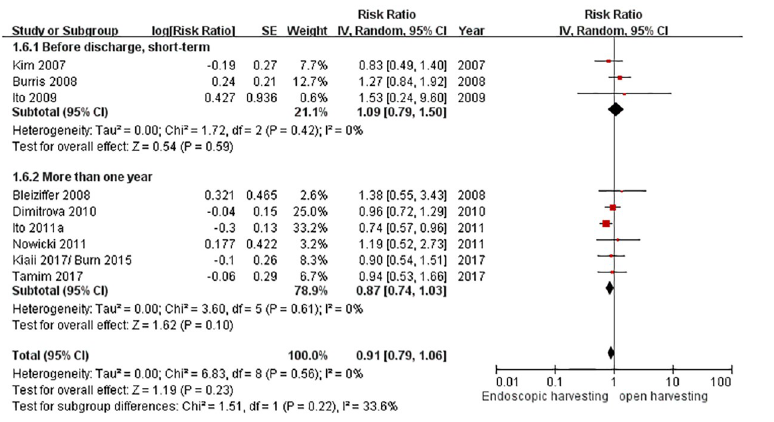
Fig 8. Forest plot for the patency